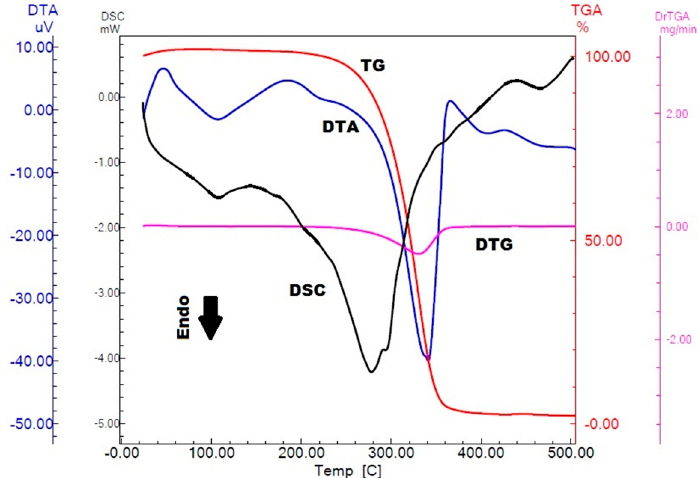
Figure 4. Differential thermal analysis (DTA), differential scanning calorimetry (DSC) and thermogravimetry (TG)/derivative thermogravimetry (DTG) curves for α , β -amyrenone in heating rate of 10.0 °C·min − 1 .